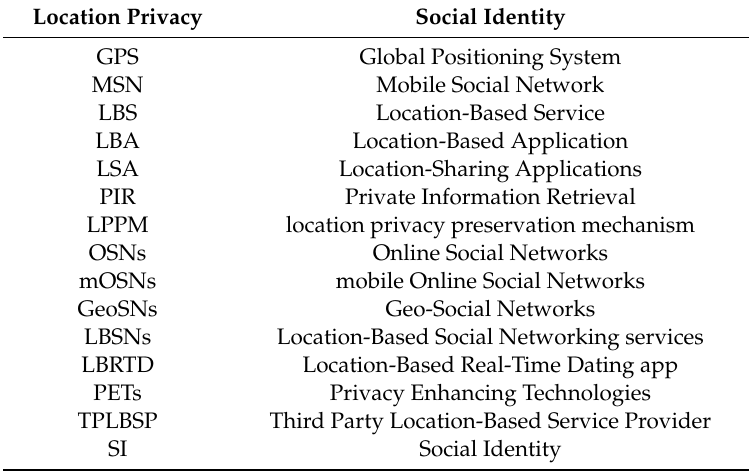
Table 6. Summary of Important Abbreviations Used in the Reviewed